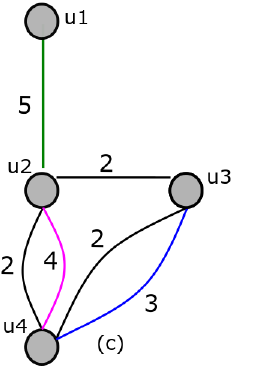
Figure 3. A query multigraph